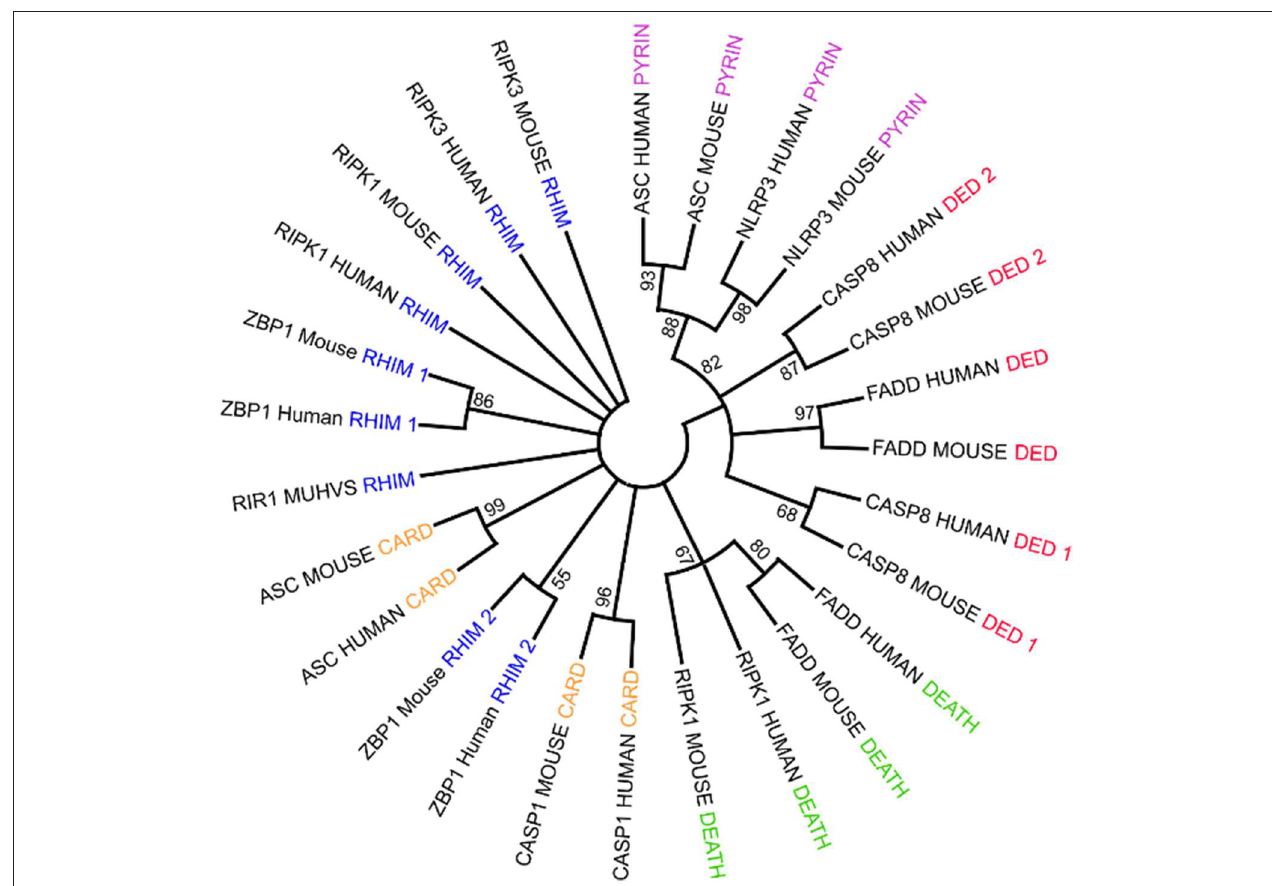
FIGURE 3 | Using phylogenetic analysis to understand the molecular mechanism governing PANoptosome assembly. Phylogenetic analysis of assembly domains present in PANoptosome components. Amino acid sequences corresponding to the domains were obtained from the Uniprot database (The UniProt Consortium, 2015 ). Multiple sequence alignment and phylogenetic analysis were performed using the Mega-X software package (Kumar et al., 2018). ClustalW was used for multiple sequence alignment. Maximum likelihood analysis with bootstrap 500 iterations was used to generate the phylogenetic tree. The consensus phylogenetic tree is shown. If a protein contains multiple copies of a domain, the domains are numbered beginning at the N-terminus. For example, the first occurrence of the RHIM domain in ZBP1 is named RHIM 1, and the second occurrence is named RHIM